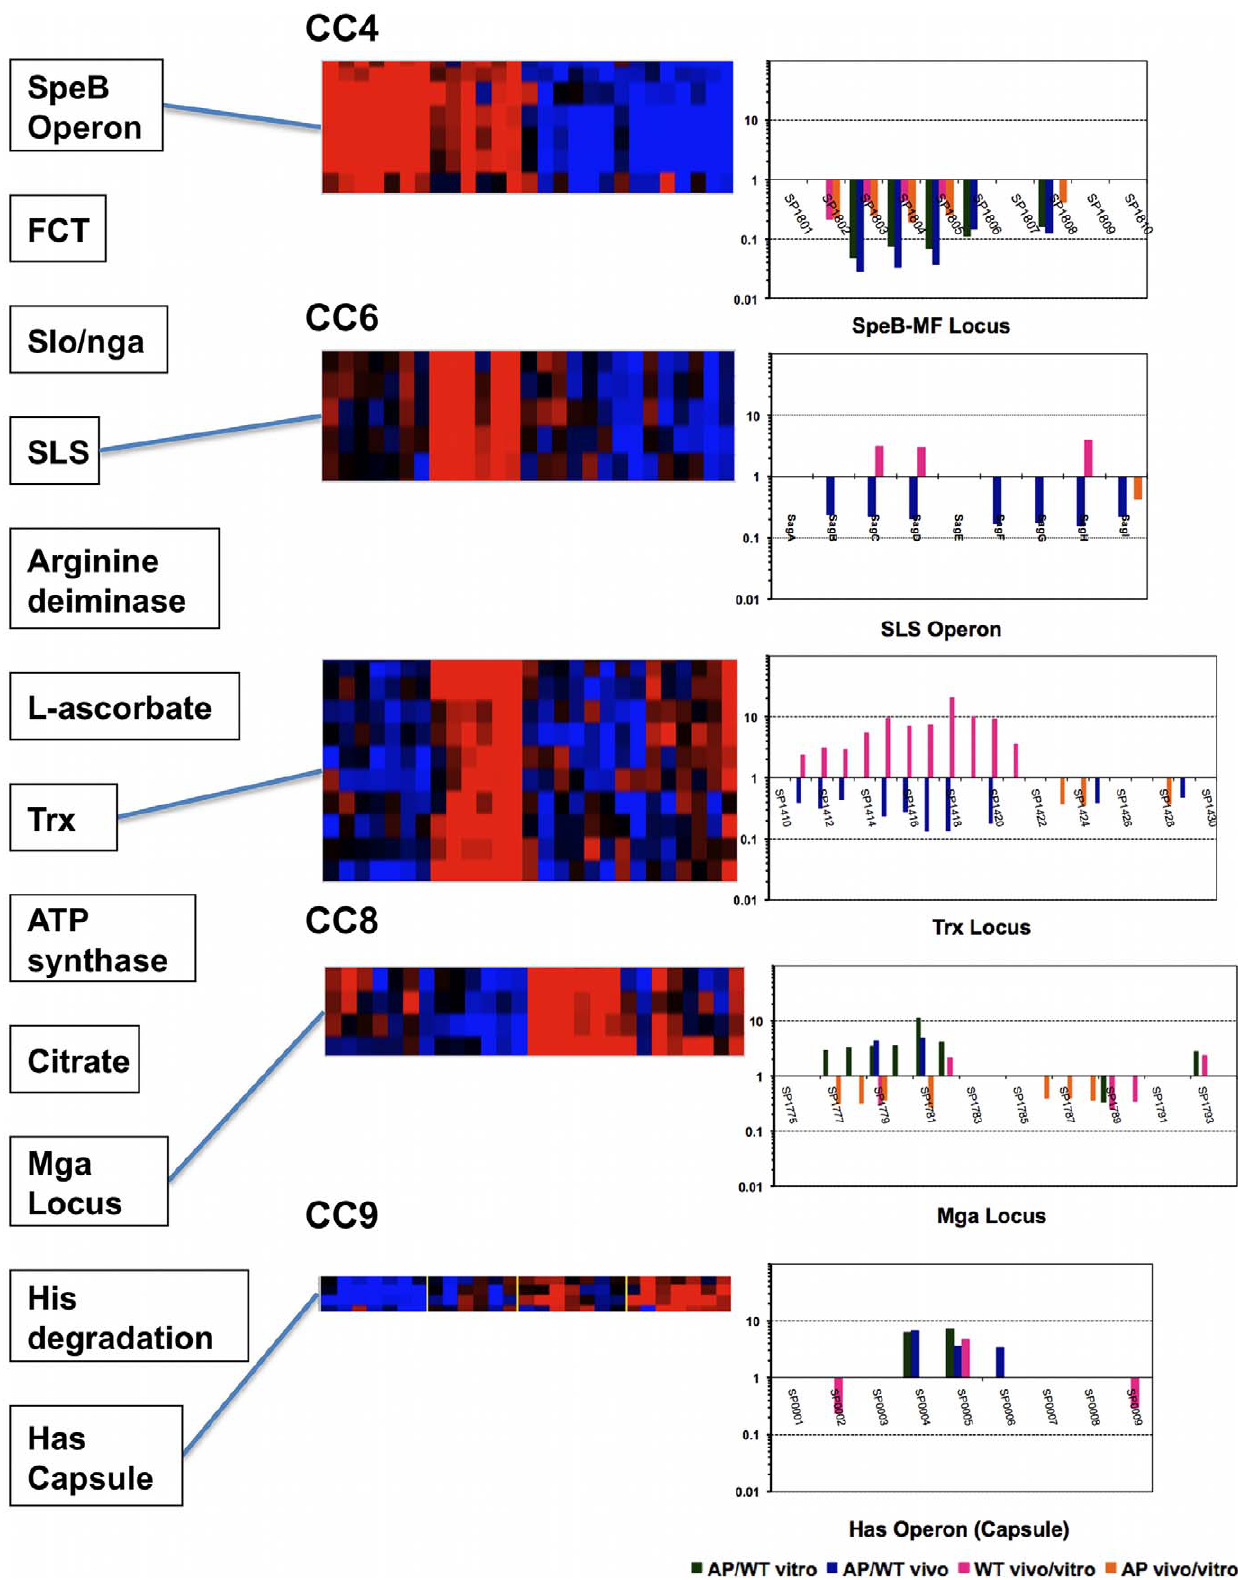
Figure 4. Examples of clusters of biological interest. The correlation between different methods of analysis of five clusters is shown. The left panel includes the different clusters detected by the NC method. The middle panels display heat maps of five coexpression clusters representing different patterns (CC4, SpeB operon; CC6, SLS operon and Trx locus; CC8, Mga locus; CC9, Has operon). The corresponding NC graphs for genes within these clusters are shown in the right panels.